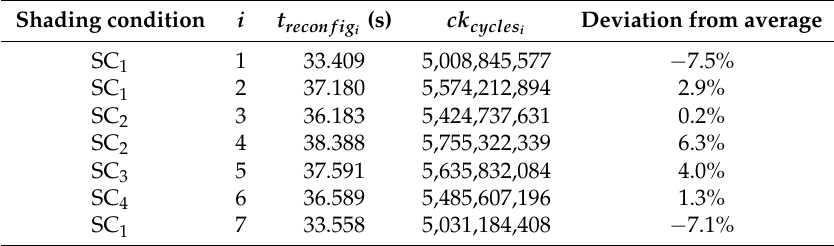
Table 3. Reconfiguration algorithm